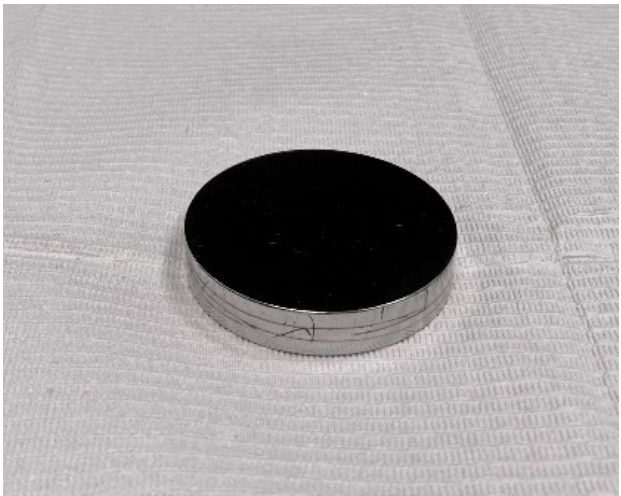
Figure 1. Stainless steel plate (50 × 10 mm 2